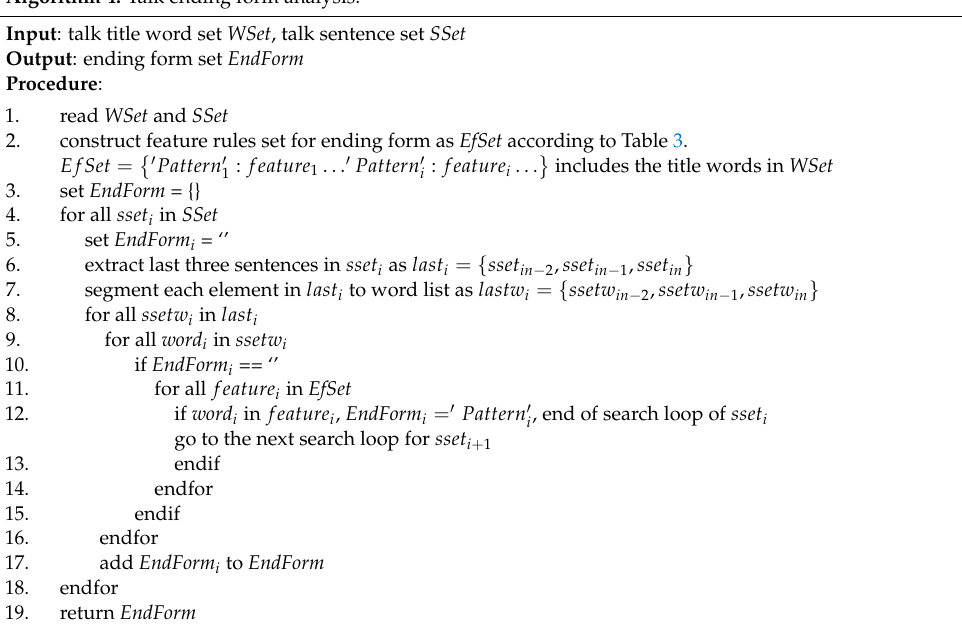
Algorithm 4. Talk ending form